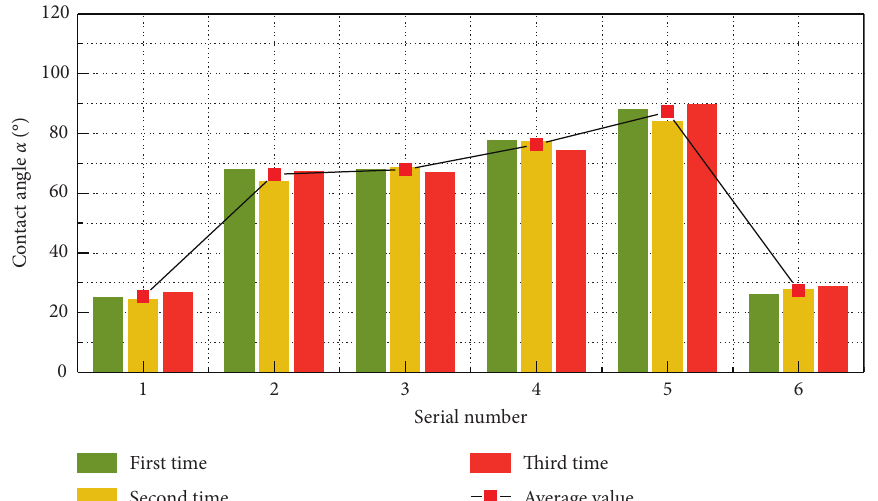
Figure 8: Measured contact angles of different coal dust samples.